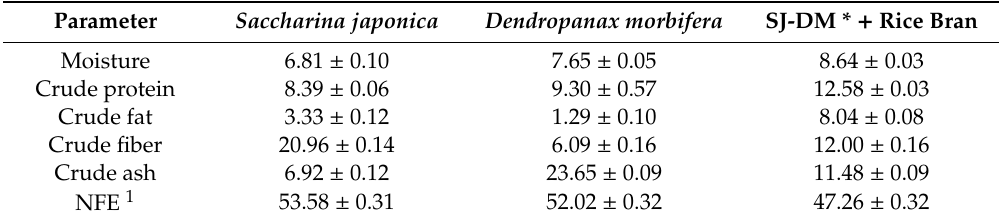
Table 1. Chemical composition (%) of ground plant powder before fermentation.